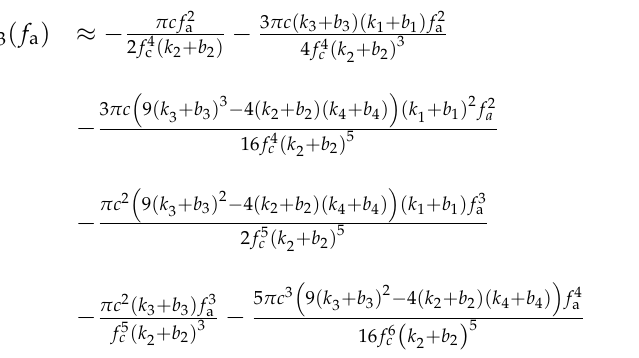
( b ) Figure 5. The range-dependent characteristic evaluation of the SRC and the residual RCM. ( a ) SRC phase of T 1 , T 6 , and T 16 ; ( b ) RCM of T 1 , T 6 , and T 16 .